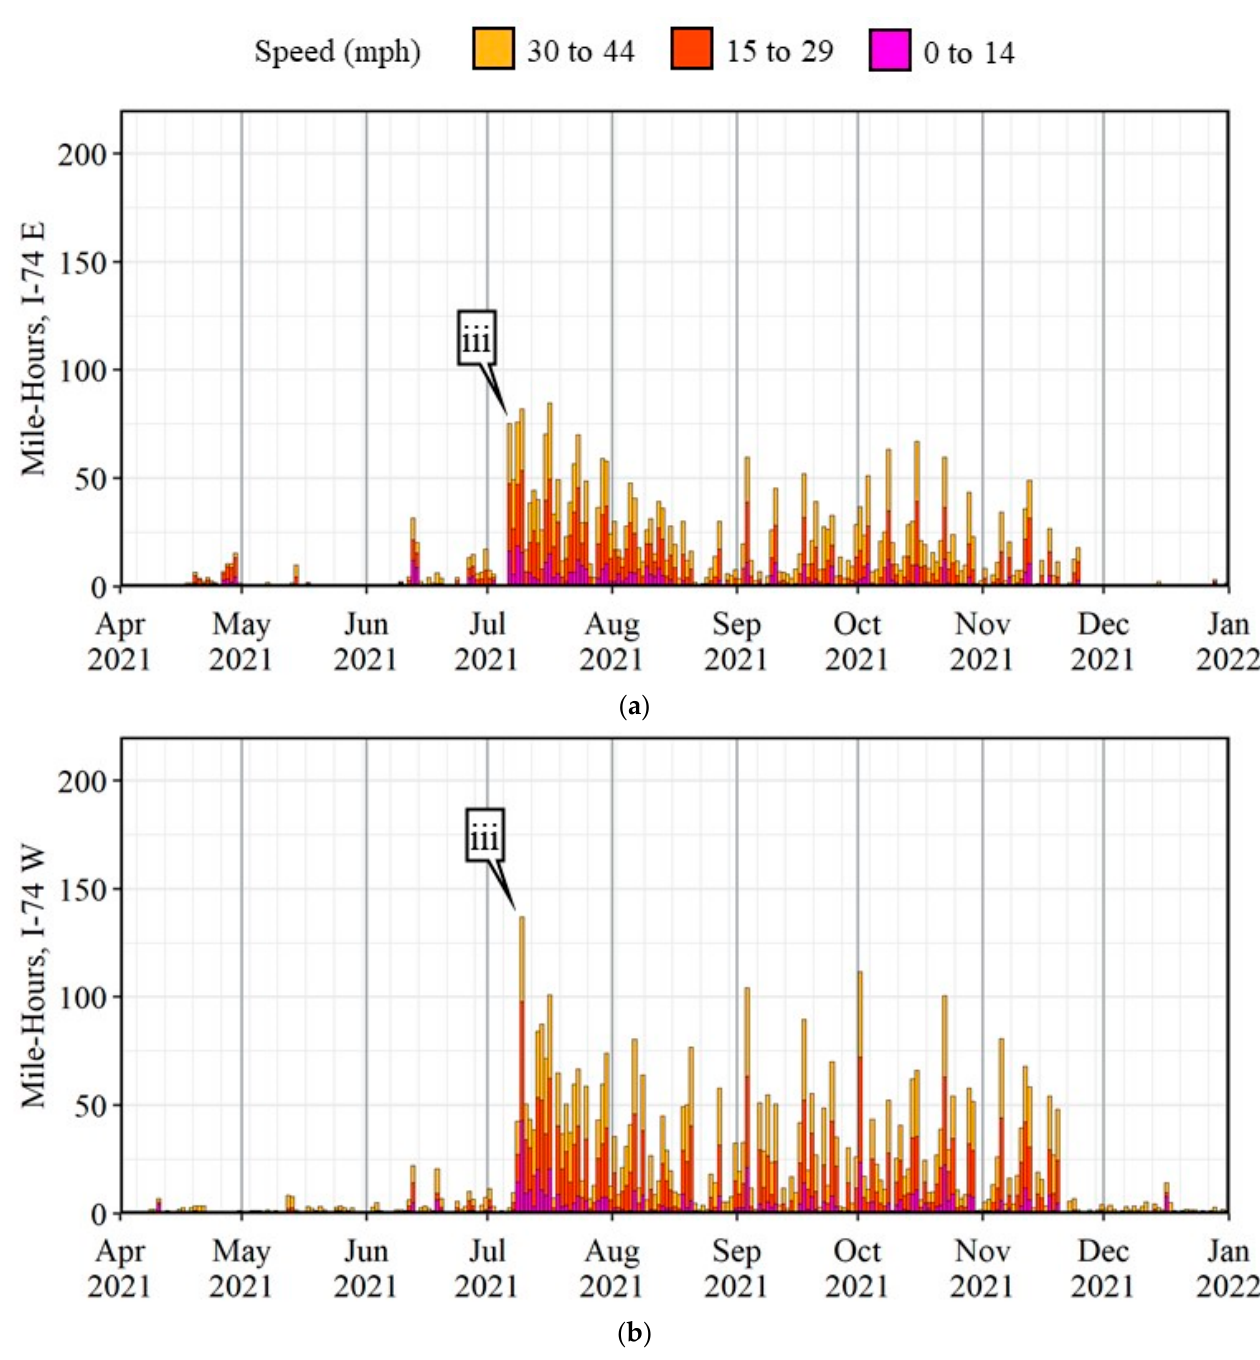
Figure 9. Daily mile–hours of congestion stacked by speed bins across I-74. ( a ) I-74 eastbound direction; ( b ) I-74 westbound direction.